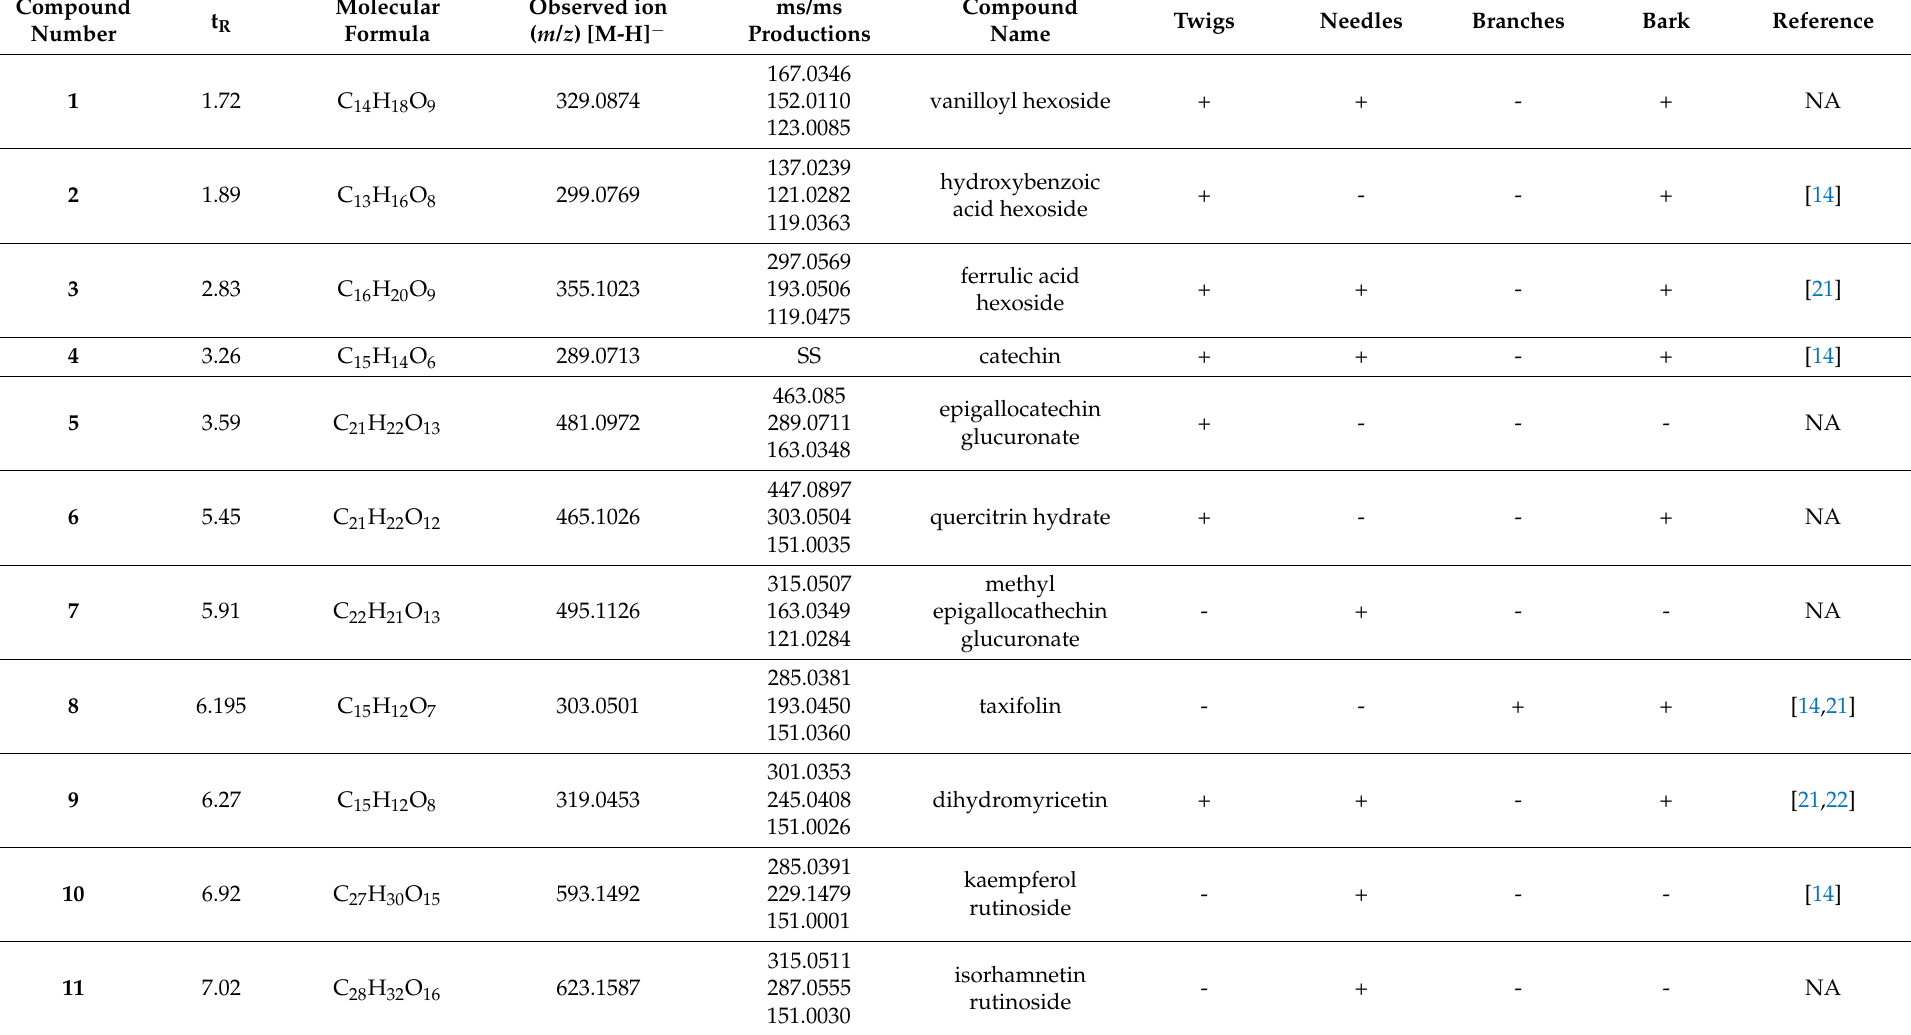
Table 1. Chemical composition of methanol extracts of different types of tissue of C. brevifolia tentatively identified by LC/Q-TOF/HRMS